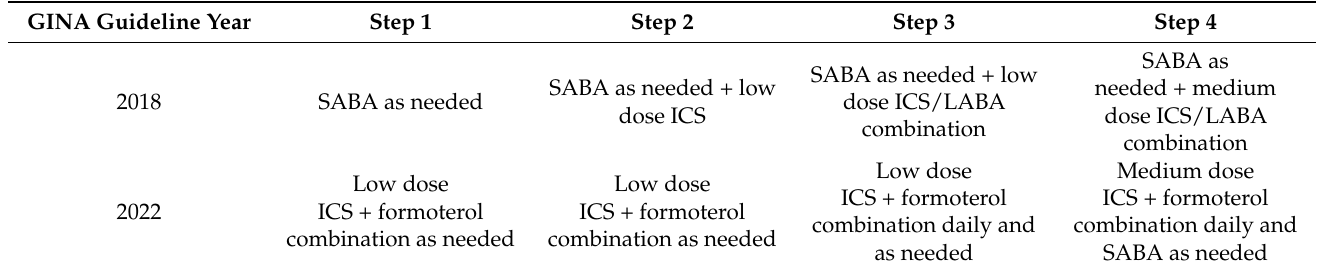
Table 1. A summary of the GINA Guidelines from 2018 compared with the GINA guidelines from